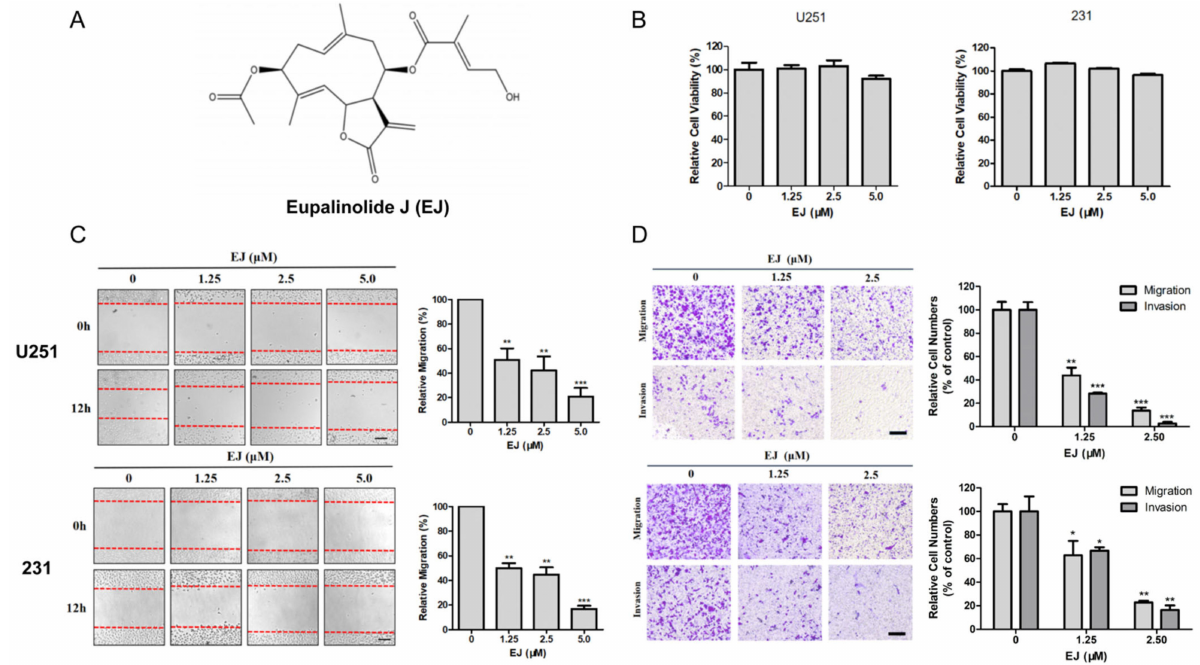
Figure 2. EJ inhibited the metastasis of cancer cells in vitro. ( A ) The chemical structure of Eupalinolide J (EJ). ( B ) Non-significant cytotoxic doses of EJ were determined on U251 and MDA-MB-231 cells by MTT assay. ( C ) EJ treatment with non-toxic doses significantly reduced wound closure rate of cancer cells in wound-healing assay. ( D ) EJ significantly inhibited cancer cell migration and invasion by transwell assay (* p < 0.05, ** p < 0.01, *** p <